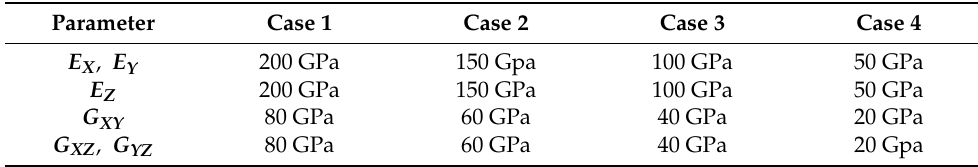
Table 2. Anisotropic material parameter